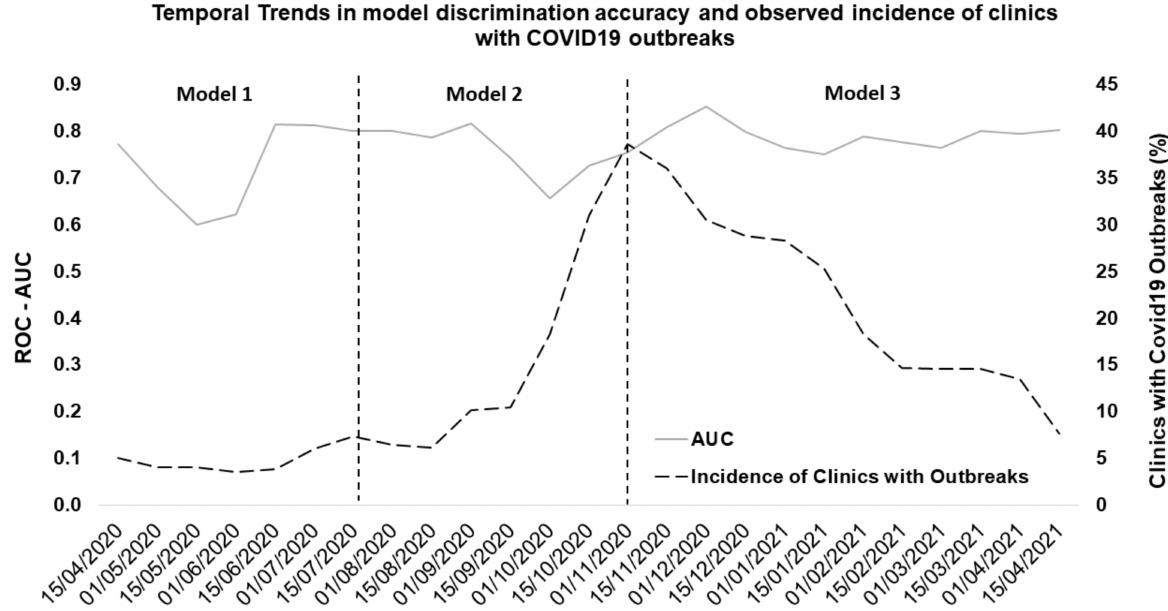
Figure 3. Model Performance and Incidence of Clinics with Outbreaks: the plot reports data related to the 1 year observa- tion